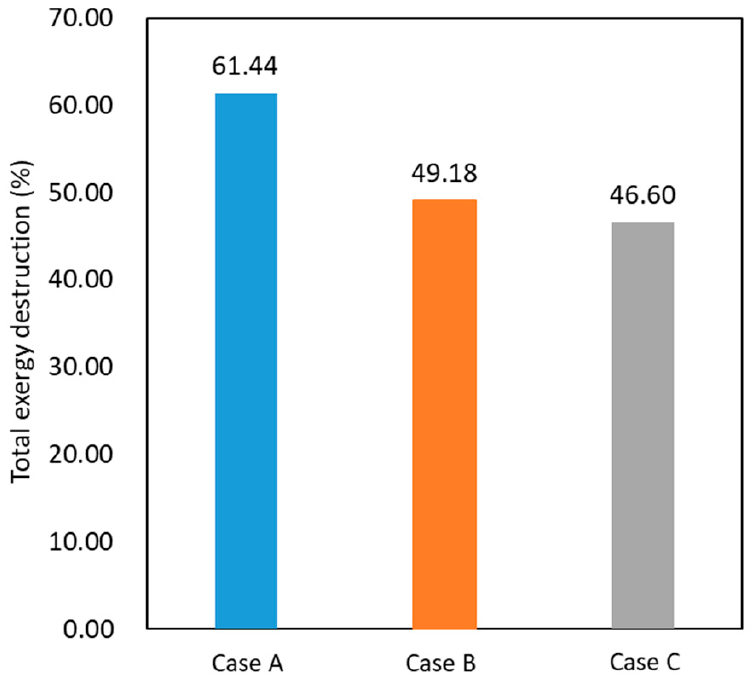
Figure 8. Total exergy destruction of the three proposed systems.